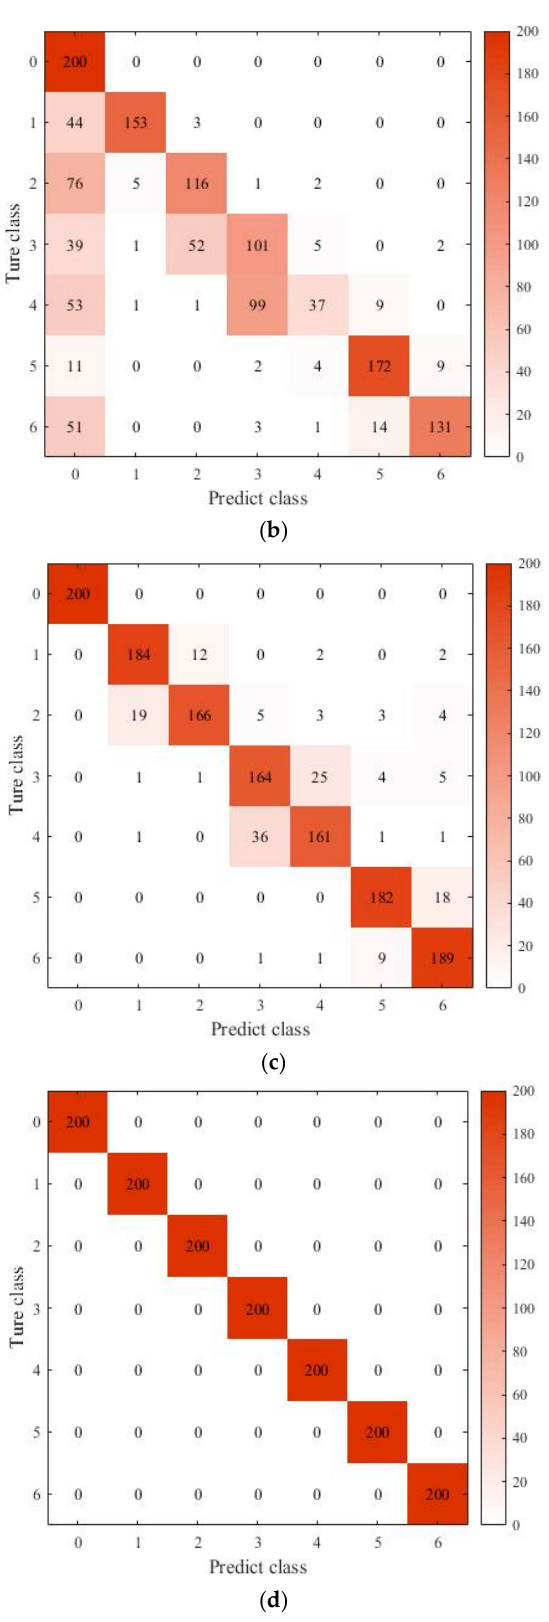
Figure 10. Confusion matrices classified by LSTM algorithm for different BR values. ( a ) BR = 0.01. ( b ) BR = 0.04. ( c ) BR = 0.2. ( d ) BR =